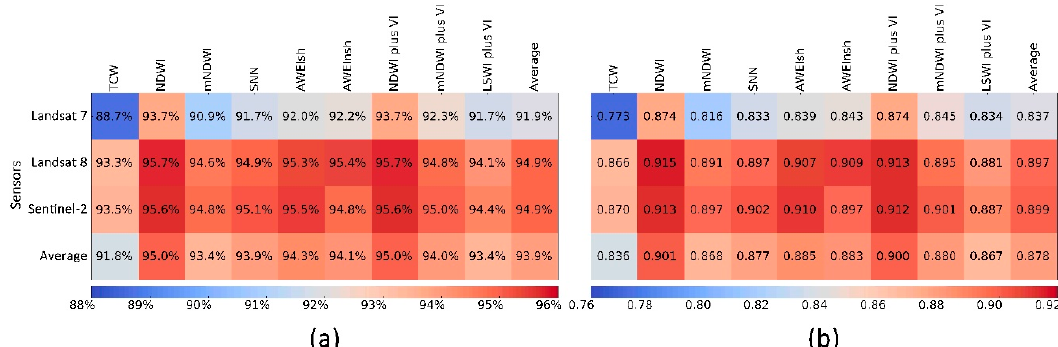
Figure 4. Overall accuracies ( a ) and Kappa coefficients ( b ) of different combinations of the nine algorithms and the three sensors (Landsat 7 ETM+, Landsat 8 OLI, and Sentinel-2 MSI).